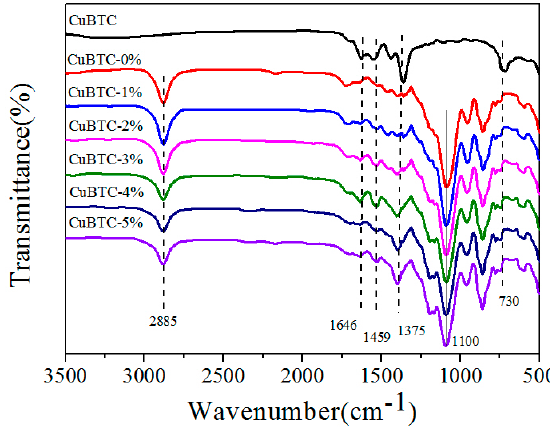
Figure 4. FT-IR spectra of the CuBTC, pristine PEG, and CuBTC-filled PEG MMMs.